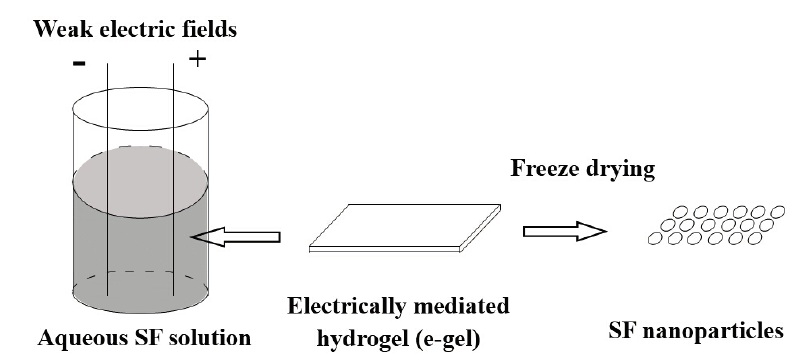
Figure 7. Schematic diagram of the electric fields method for preparing SF nanoparticles.